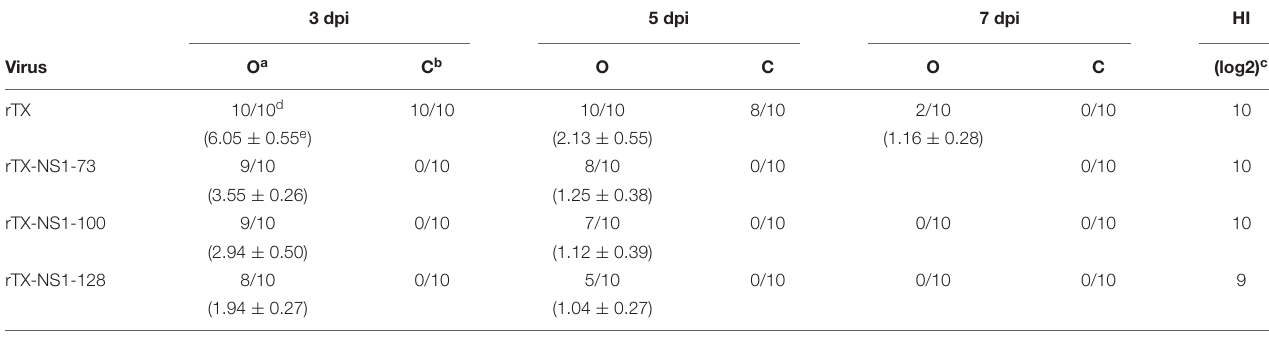
TABLE 2 | Viral shedding and titration in chicken oropharyngeal and cloacal swabs.